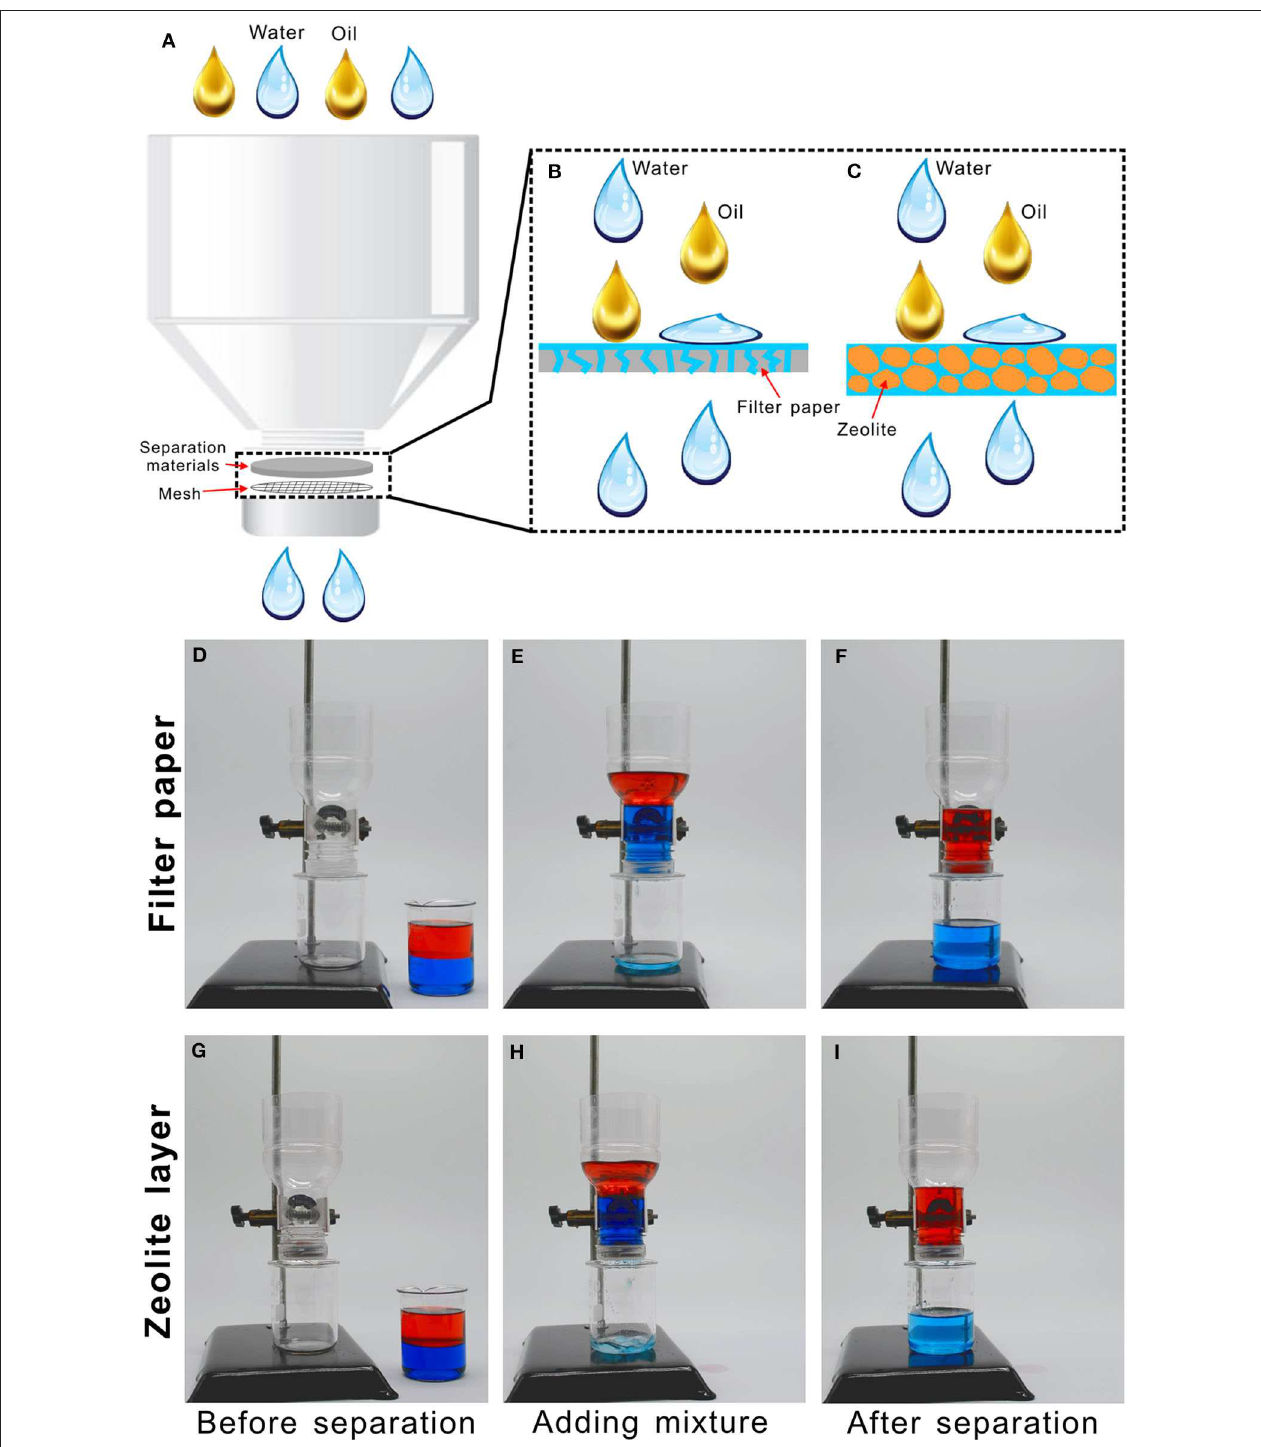
FIGURE 4 | Oil/water separation by using the filter paper or zeolite layer as the separating materials. (A) Schematic of the separation setup. (B,C) Separating mechanism based on the pre-wetted (B) filter paper or (C) zeolite layer. (D–I) Process of oil/water separation by using the pre-wetted (D–F) filter paper or (G–I) zeolite layer. Water was dyed by methylene blue and oil was dyed by Oil Red O.